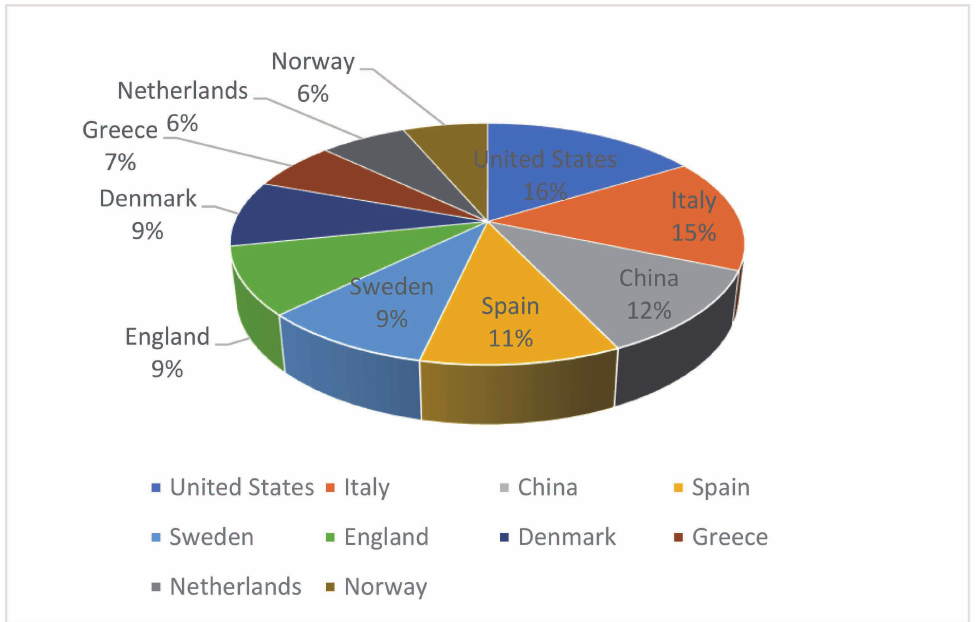
Figure 5. Proportion of country-related